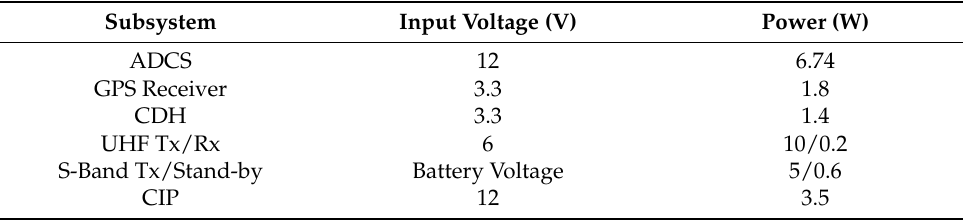
Table 2. Power consumption of IDEASSat